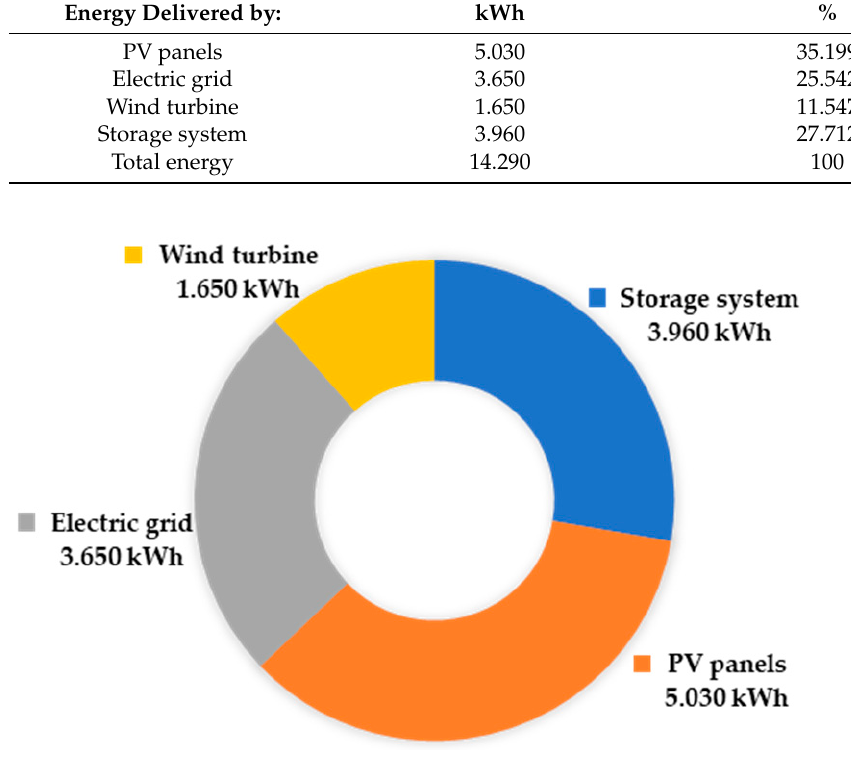
Figure 11. Distribution of electricity produced by each source. Second scenario data.